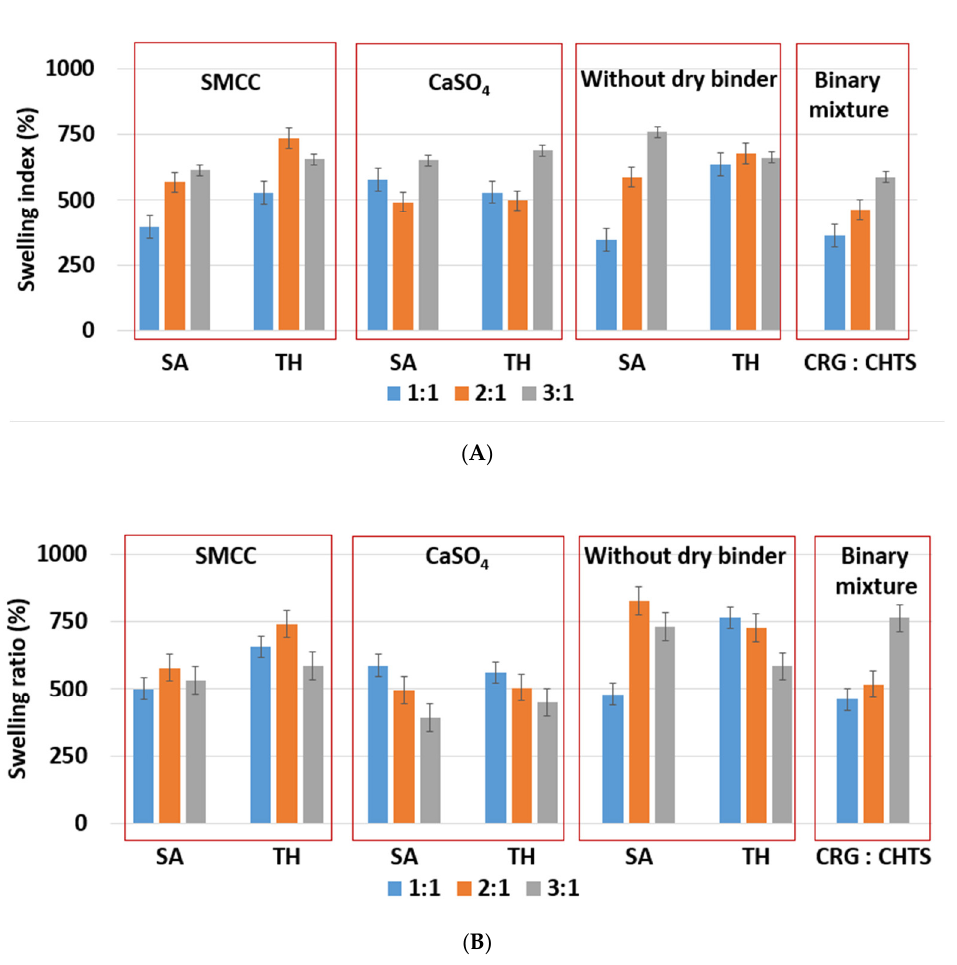
Figure 4. ( A ) The effect of CRG/CHTS ratio (1:1; 2:1; 3:1), type of dry binder (Prosolv ® SMCC 90, CaSO 4 ), and model drug solubility (TH, SA) on swelling behavior of studied matrix tablets in acidic medium (2 h). ( B ) The effect of the CRG/CHTS ratio (1:1; 2:1; 3:1), type of dry binder (Prosolv ® SMCC 90, CaSO 4 ), and model drug solubility (TH, SA) on the swelling behavior of the studied matrix tablets in phosphate buffer at pH 6.8 (2 h in acidic medium then 2 h in phosphate buffer).